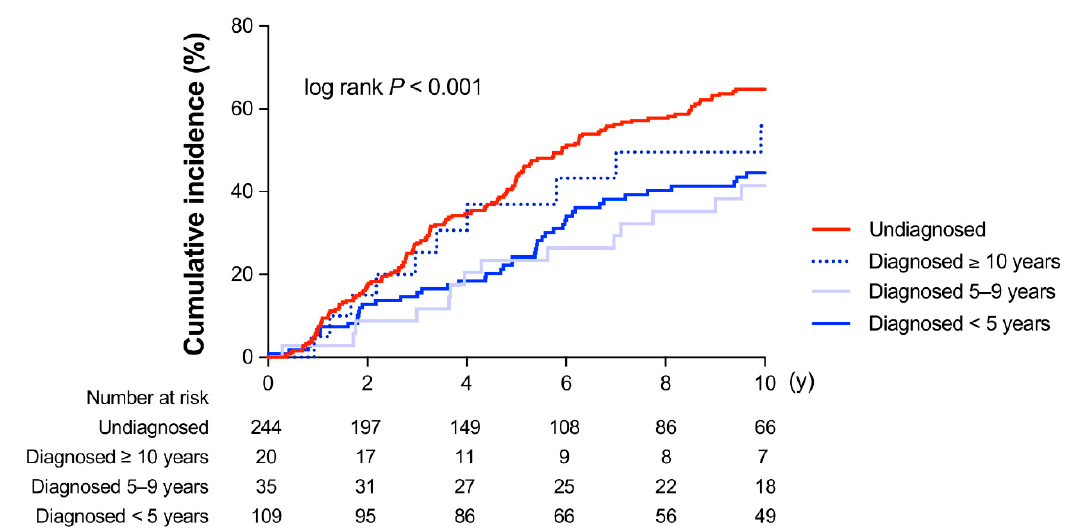
Figure 2. Kaplan–Meier curves for the development of diabetic kidney disease (DKD: eGFR < 60 mL/min/1.73 m 2 or proteinuria) in patients with diagnosed (blue lines) or undiagnosed (red line) diabetes mellitus. The diagnosed patients were categorized accordingly: Diagnosed < 5 years, Diagnosed 5–9 years, Diagnosed ≥ 10 years duration.